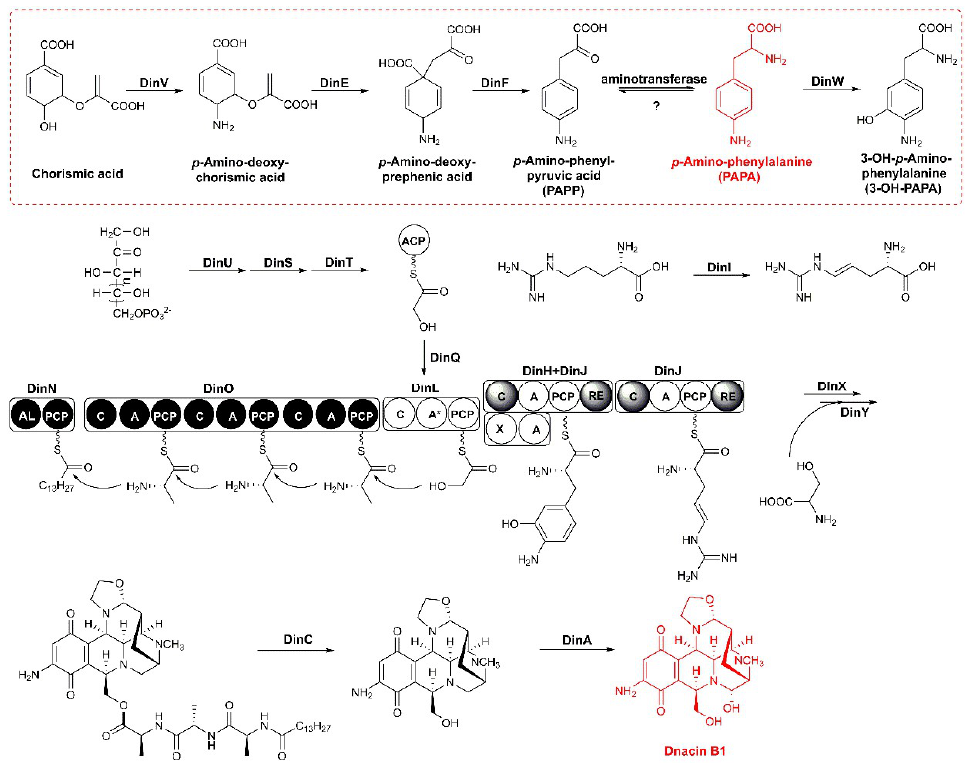
Figure 3. Proposed biosynthetic pathway of dnacin B1. The biosynthetic pathway of assumed precursor 3-OH-PAPA was presented in red dotted box. 3-OH-PAPA was presented in red dotted